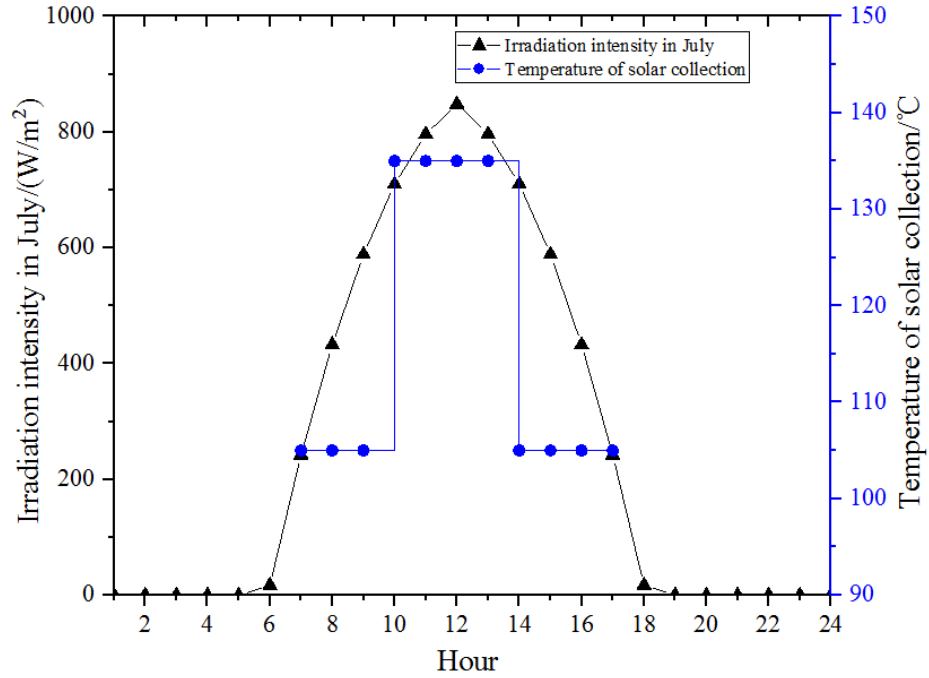
Figure 9. Schematic of the temperature of solar collection on a typical day in July.